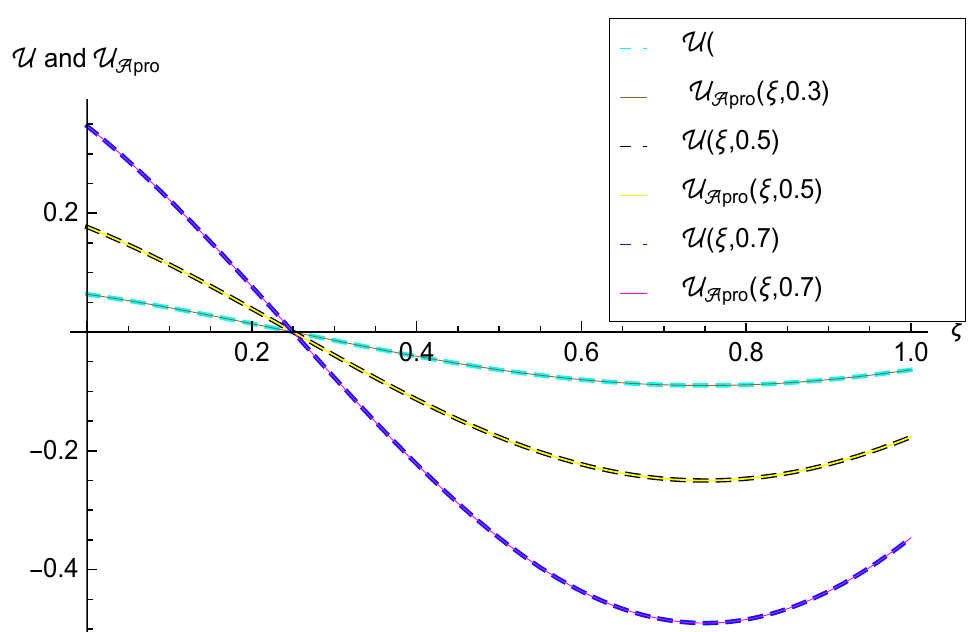
Figure 13. x -Curves of the exact and numerical solutions of U ( ξ , τ ) of the problem (33), where